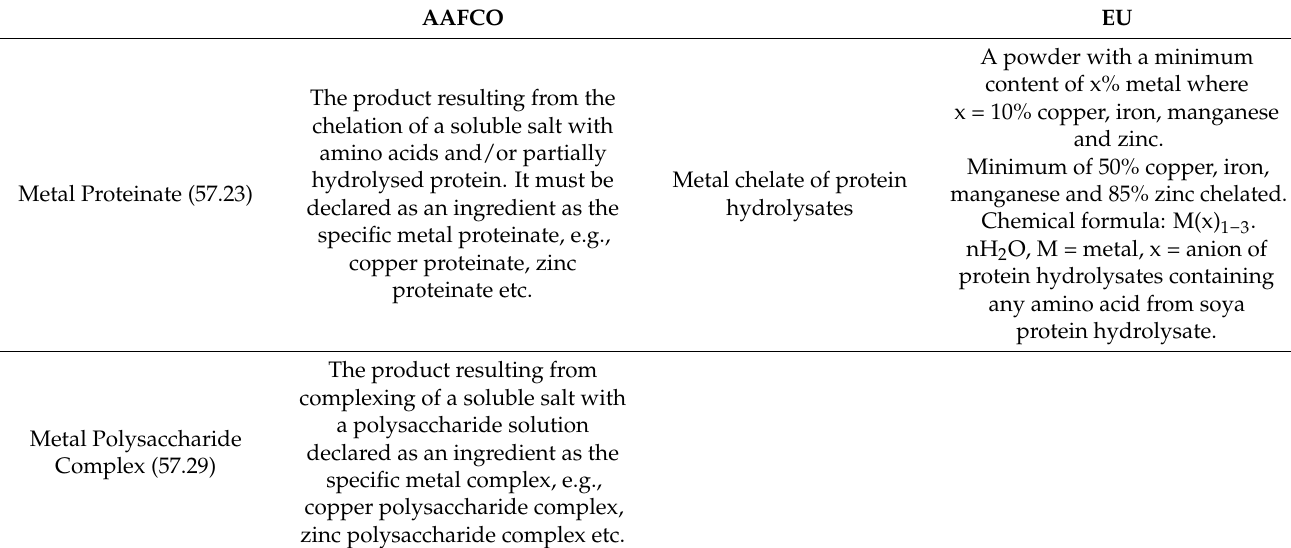
Table 2. Organic trace mineral definitions comparing AAFCO and EU